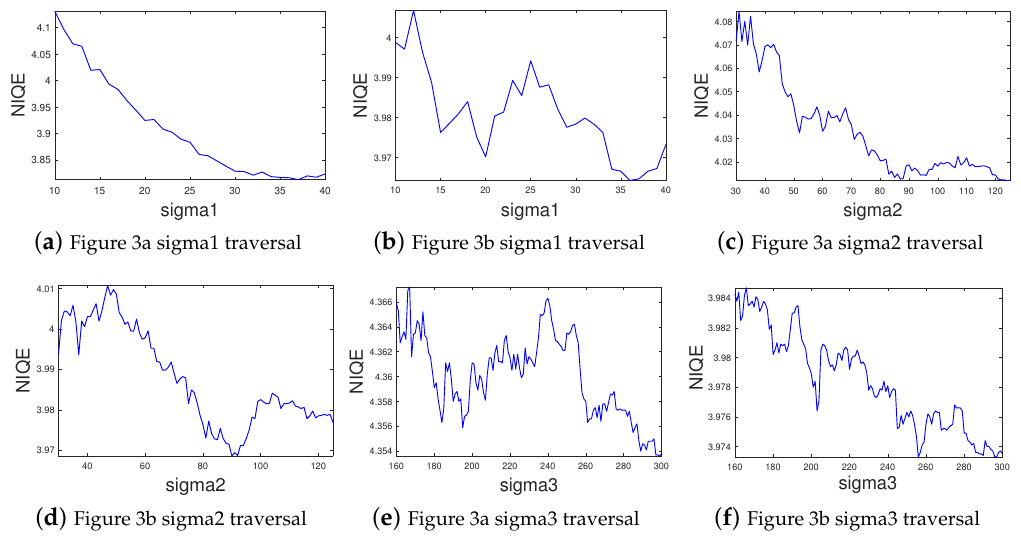
Figure 5. The result of traversing sigma1, sigma2 and sigma3 of the two pictures in Figure 4.